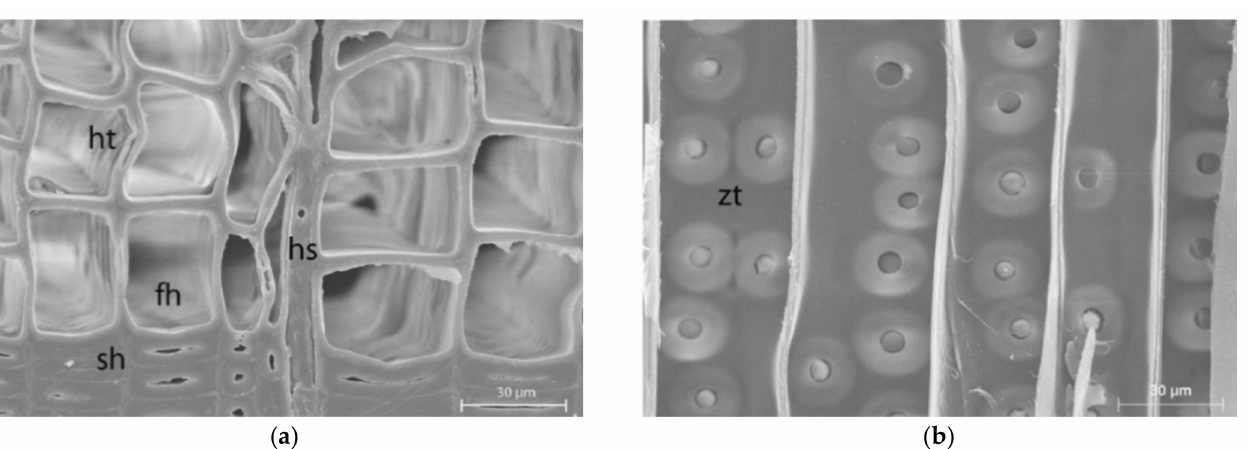
Figure 3. SEM images of softwood in cross-section (fh earlywood, sh latewood, ht bordered pits, hs ray) ( a ) and in radial section (zt twin bordered pits) ( b ) Reprinted with permission from Ref. [45]. 2012, Rosenthal.